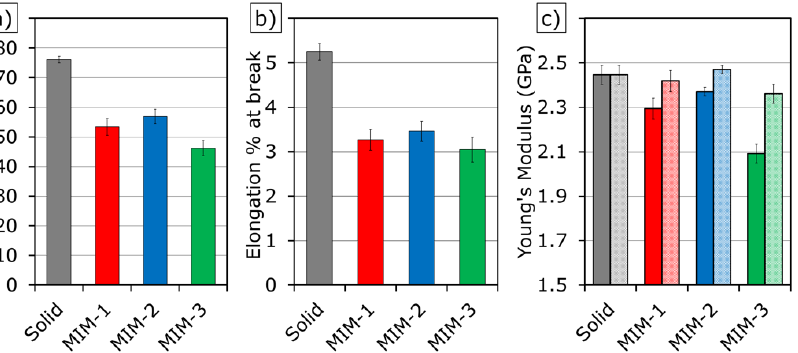
Figure 7. Mechanical properties of tensile test bar samples: ( a ) ultimate strength; ( b ) elongation at break of samples; ( c ) Young’s Modulus and specific Young’s modulus of samples. Bars with a textured pattern show the specific Young’s modulus.